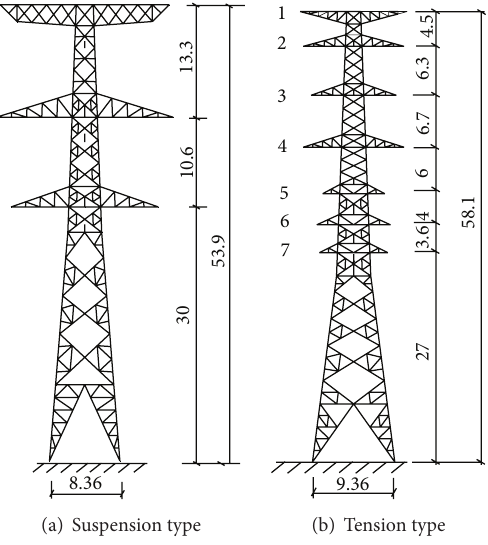
Figure 1: Transmission tower model